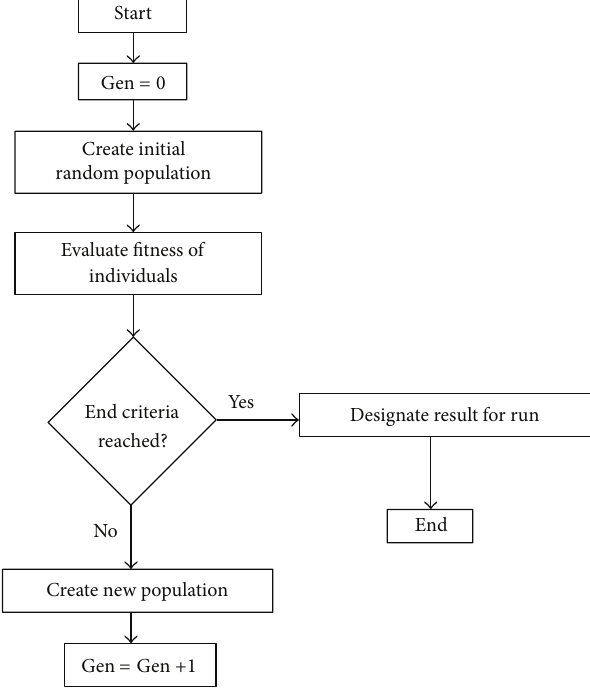
Figure 1: Flowchart of the evolutionary